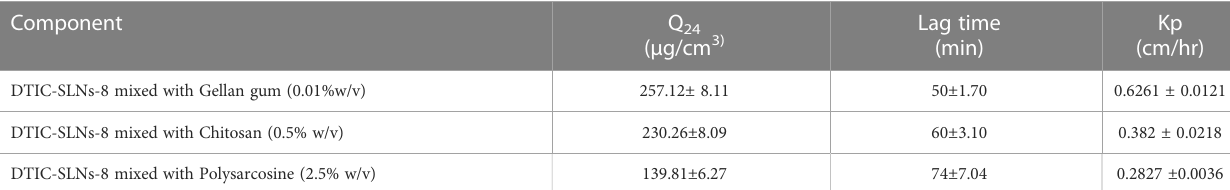
TABLE 5 DTIC-SLNs-8 combined with Gellan gum (0.01 % w/v), Chitosan (0.5 % w/v), and Polysarcosine (2.5 % w/v) permeation parameters (means SD,